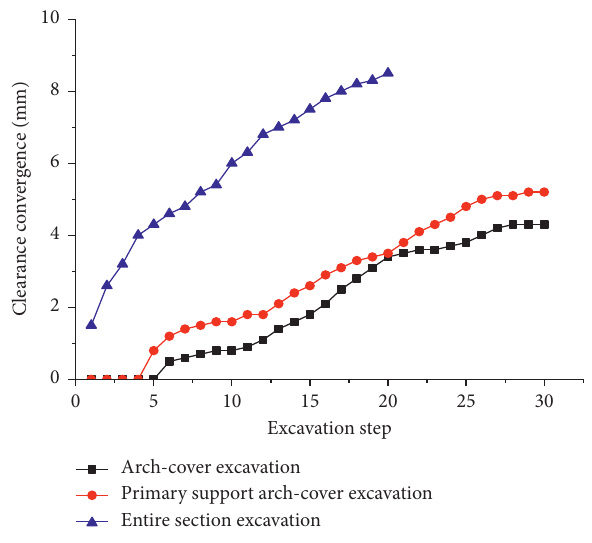
Figure 17: Clearance convergence curves with sustainable excavation.